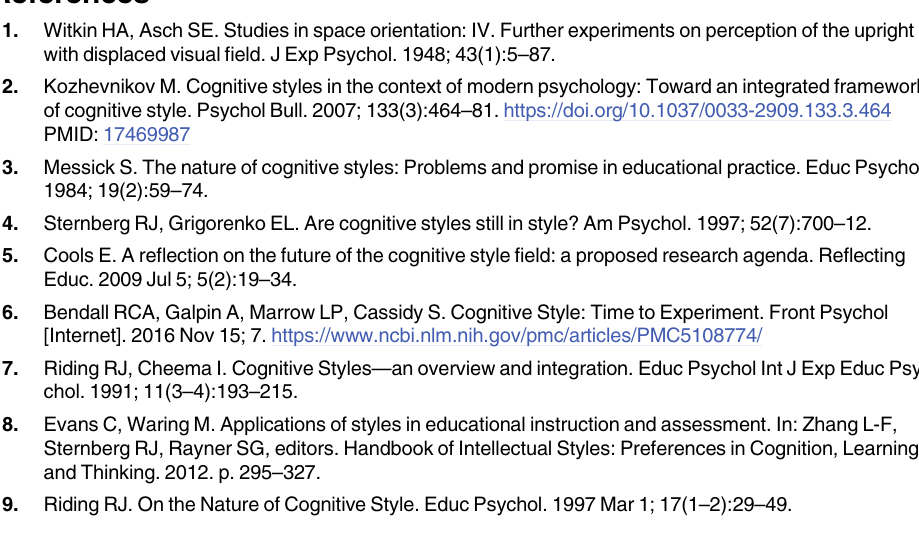
S3 Table. Descriptive statistics, study 2. Means and SD for the demographic and question- naire data for men (n = 42) and women (n = 77) separately Results from the t-tests, Cronbach’s alphas and omegas are equally presented. Significant results are given in bold. Last columns present sample comparison with a French student population